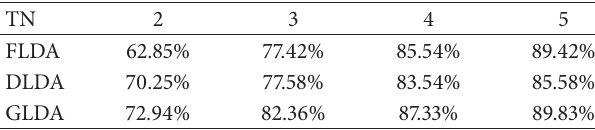
Table 2: Recognition rates on FERET